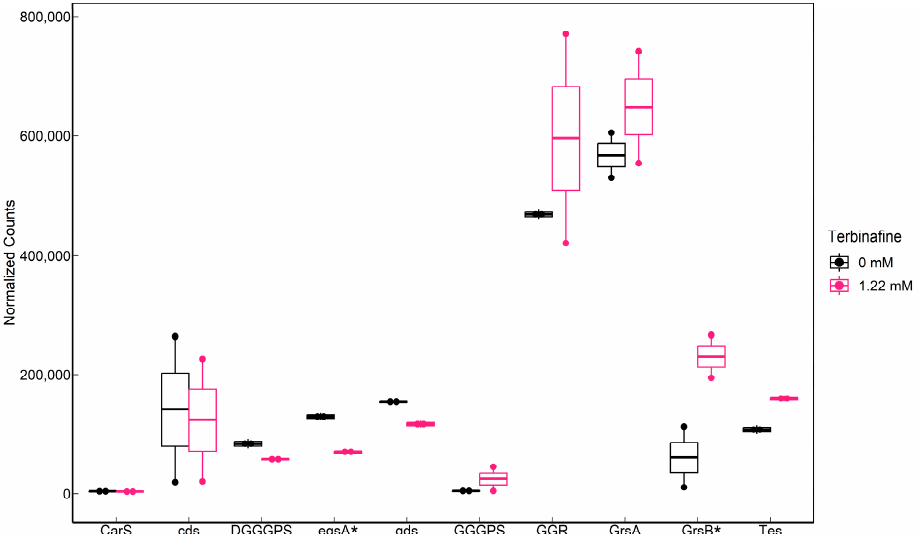
Figure 9. Transcriptomic response of lipid biosynthesis genes in S. acidocaldarius to terbinafine: Significantly affected genes ( p -adjusted < 0.05) are indicated by an asterisk (*) on the x-axis. Counts were normalized for sequencing depth using the mean ratio method in DESeq2. cds : saci_1498 (calditol synthase), carS : Saci_0897 (CDP-archaeol synthase), DGGGPS: Saci_1565 (Digeranylgeranylglycerol phosphate synthase), egsA : Saci_0640 (Glycerol-1-phosphate dehydrogenase), gds : Saci_0092 (geranylgeranylpyrophosphate synthase), GGGPS: Saci_0728 (geranylgeranylglycerolphosphate synthase), GGR: Saci_0986 (geranylgeranyl reductase), grsA : Saci_1585 (GDGT cyclization A), grsB : Saci_0240 (GDGT cyclization B), and Tes : Saci_0703 (tetraether synthase) .